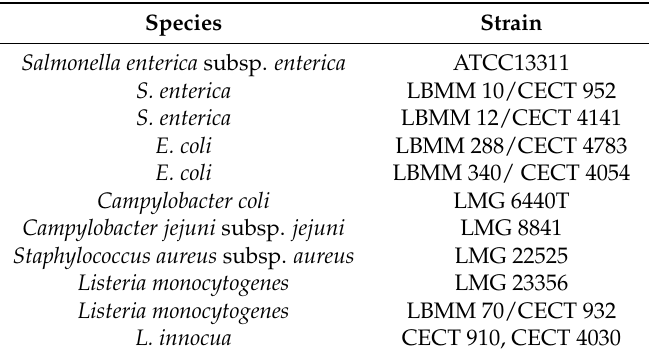
Table 1. List of strains used in this